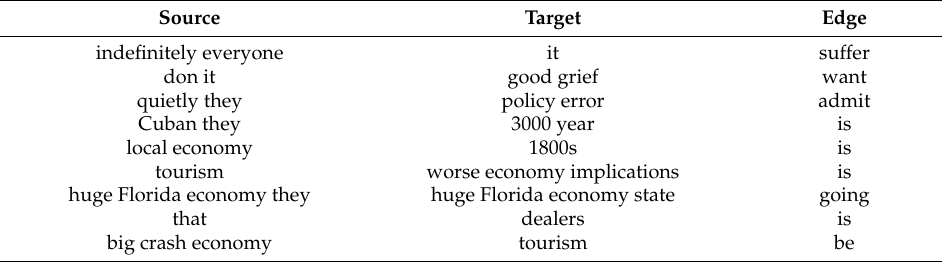
Table 7. Cluster wise Entity Relation Extraction–2.